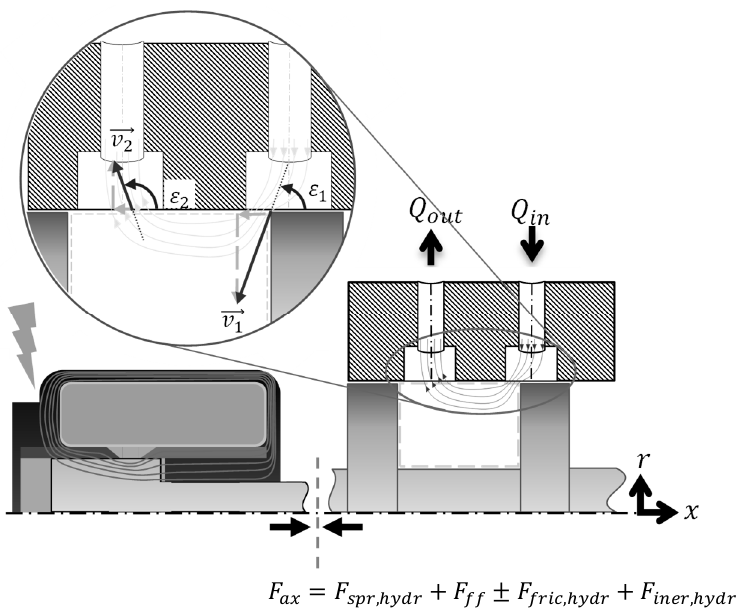
Figure 1. Valve with Solenoid and Axial Forces.